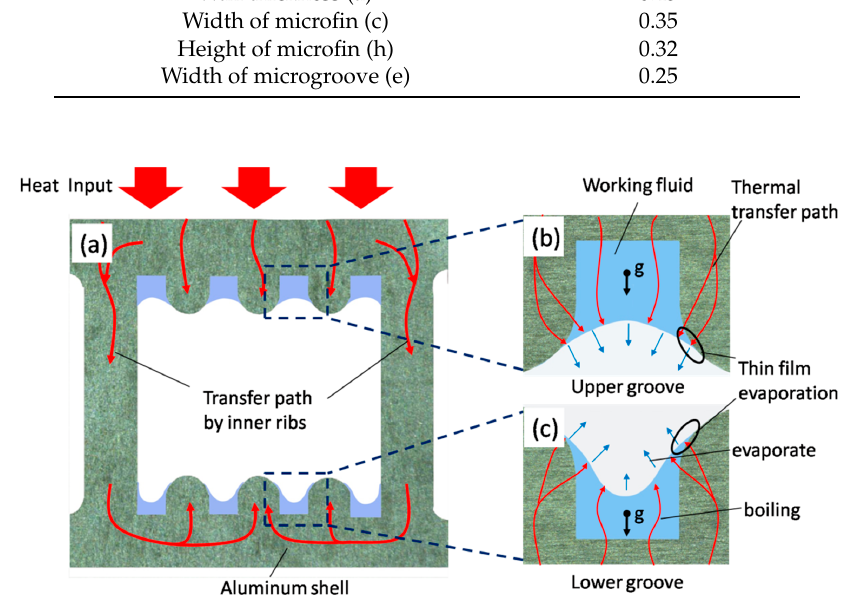
Figure 2 . Schematic of heat transfer path and liquid film distribution inside a channel while heated from the upper surface. ( a ) A view of the whole channel cross-section; ( b ) upper groove liquid distribution; and ( c ) bottom groove liquid distribution.